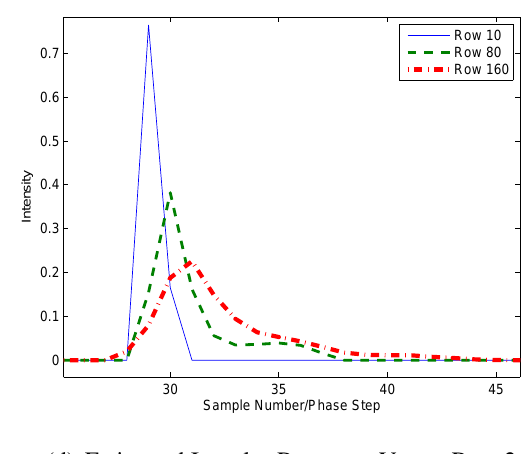
(d) Estimated Impulse Response Versus Row